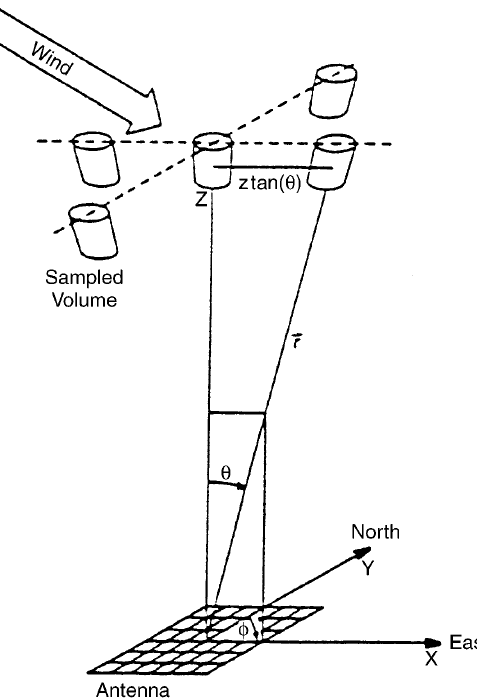
Fig. 10. Illustration of the Doppler-beam-swinging (DBS) technique for wind measurements with a five-beam radar. The altitude, range, and zenith angle are denoted by z , r , and h , respectively